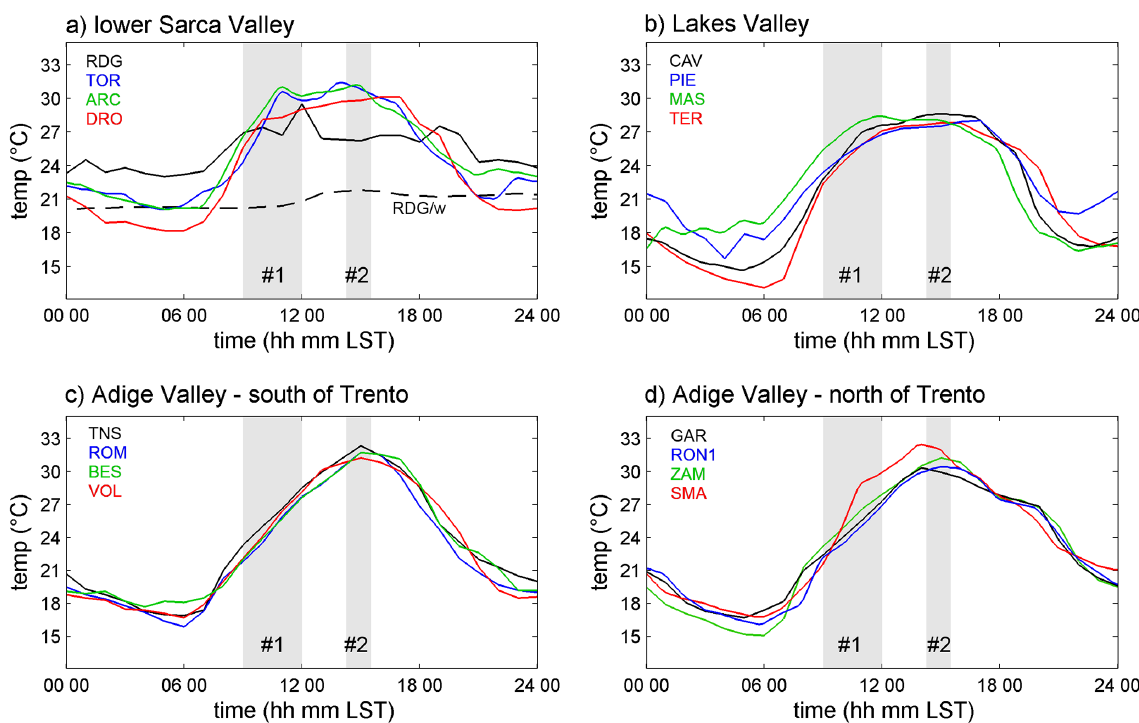
Figure 4. Observations of 2m a.g.l. air temperature for 23 August 2001, grouped by geographic area. Notice that RDG/w series is the Lake Garda water temperature measured at RDG. See Fig. 2 and Table 2 for names and locations of the AWSs. The duration of flights 1 and 2 is indicated by the grey